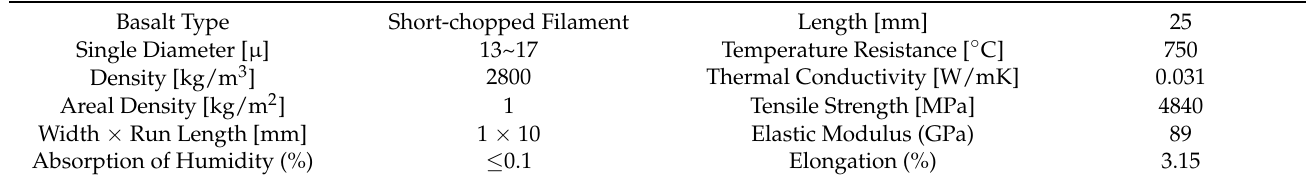
Table 2. Parameter of basalt fiber in the study.